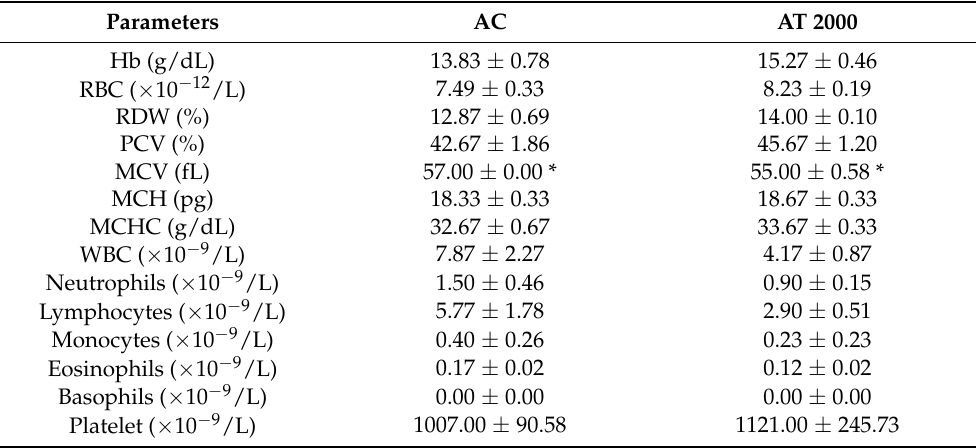
Table 5. Effect of E. tapos yoghurt on haematology parameters in acute toxicity study. Values expressed as mean ± SEM. (*) indicates a significant difference at p < 0.05.